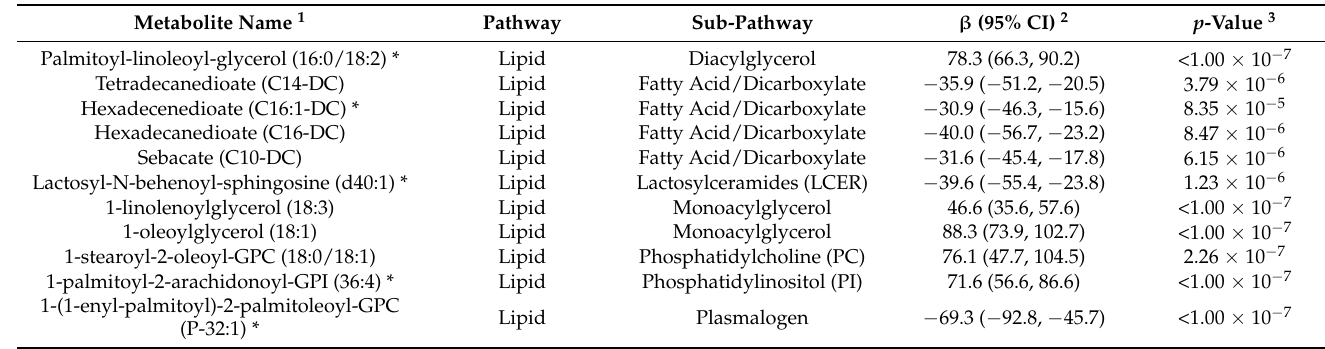
Table 4. Prospective associations between the selected metabolites associated with sugar-sweetened beverage intake in childhood and fasting triglycerides across childhood and